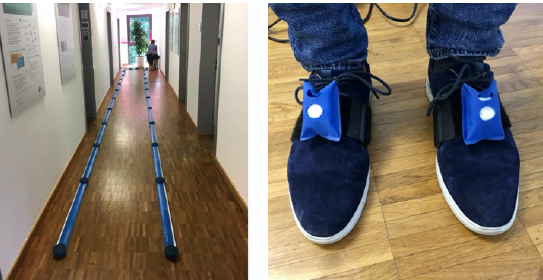
Figure 3. Gait data recording set-up. Left: the 10 m OptoGait walkway. Right: the IMUs were fixed on top of the